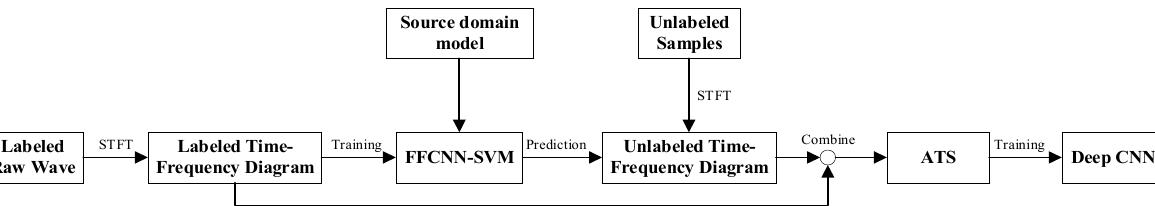
Figure 4. Block diagram of the process of transferring knowledge from a shallow model to a deep learning model.